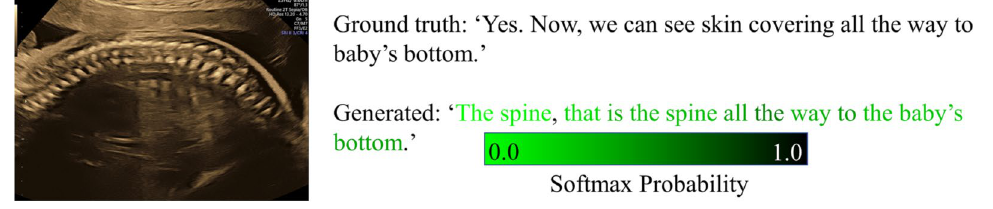
Figure 8. Image captioning: the ground truth and a generated caption are shown for the fetal spine. The darker the green color, the higher probability of the associated with a generated word (Softmax probability).